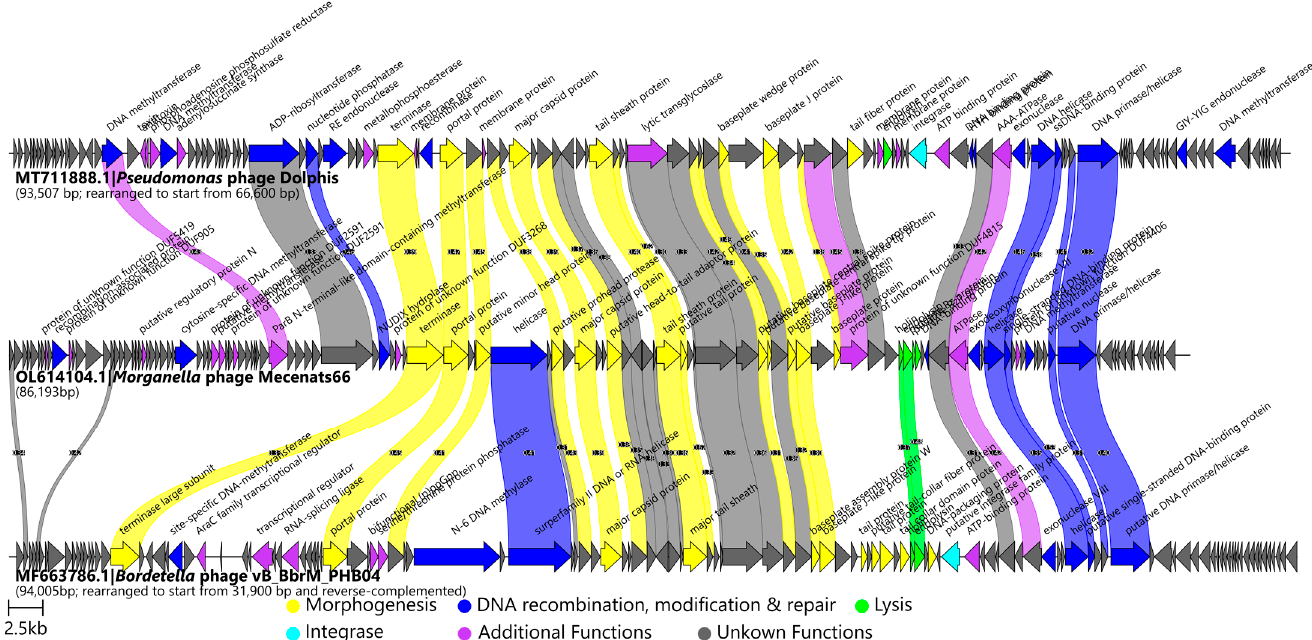
Figure 3. Pairwise genome organization and encoded protein comparison of Morganella phage Mecenats66 ( middle ) to Pseudomonas phage Dolphis ( upper ) and to Bordetella phage vB_BbrM_PHB04 ( lower ). Genomes are drawn to scale, and the genomes of Dolphis and PHB04 were reordered as indicated to ensure collinearity with Mecenats66; the scale bar indicates 2500 base pairs. Arrows representing open reading frames point in the direction of the transcription and are color-coded based on the function of their putative product according to the legend. Slanted labels above the arrows indicate the predicted function for the given ORF putative product in the case it had a function assigned (original annotations were retained for Dolphis and PHB04; predicted Mecenats66 ORF123 crossing the genome termini junction is not shown). Ribbons connect homologous proteins of phages and are colored according to the predicted functional group of the respective Mecenats66 ORF product. Ribbon labels indicate the pairwise similarity between the connected ORF products (for products having ≥ 30% identity). Comparisons were carried out using clinker (v.0.0.23.; [65]).